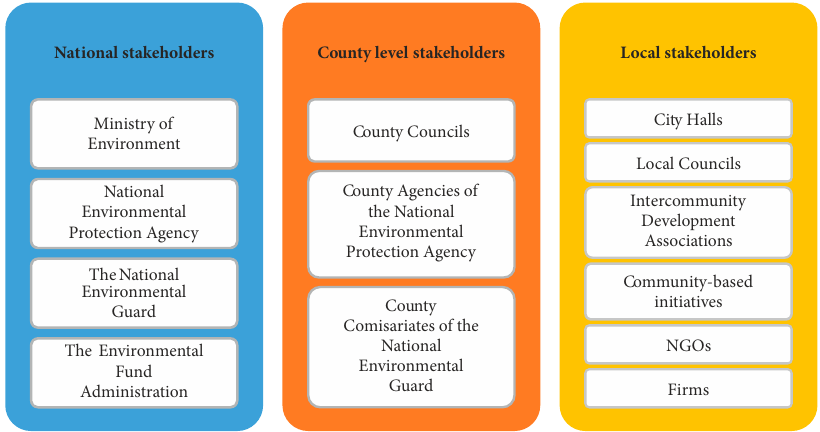
Figure 6. Stakeholders involved in the waste management system in Romania at national, county and local